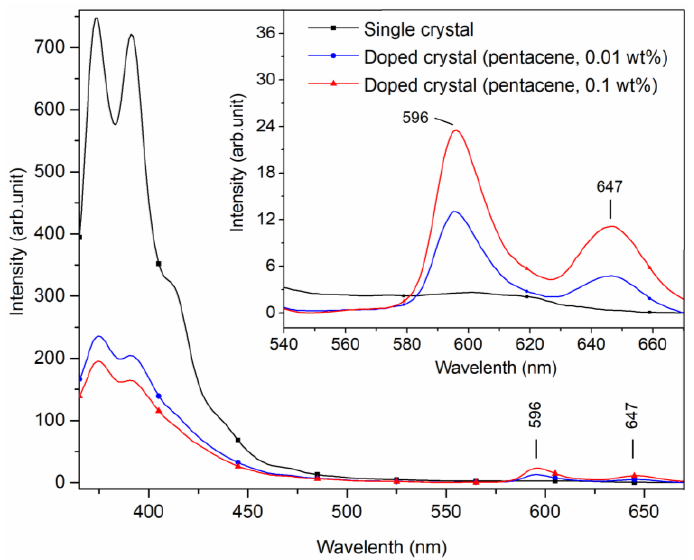
Figure 5. Fluorescence spectra of pure and pentacene-doped p-terphenyl crystals ( λ ex = 345 nm).